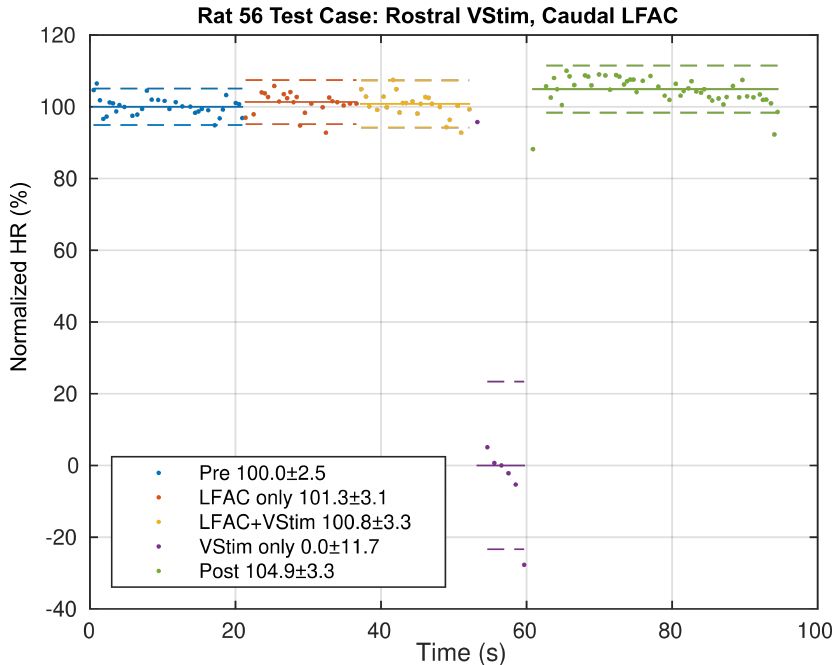
Figure 4. Example of Normalized HR (estimating RR rate derived percent block) as a function of epoch for the test case where vagal stimulation is presented rostral to the LFACb waveform along the nerve. In this example, 100.8 ± 3.3% block was achieved in the ’LFACb+VStim’ epoch. A negative percent block, as in the ’VStim only’ epoch, indicates that the data point was below the normalized median percent block in the ’VStim Only’ epoch. The solid straight lines indicate medians and the dashed straight lines indicate one standard deviation. Legend values are % Block ± SD.